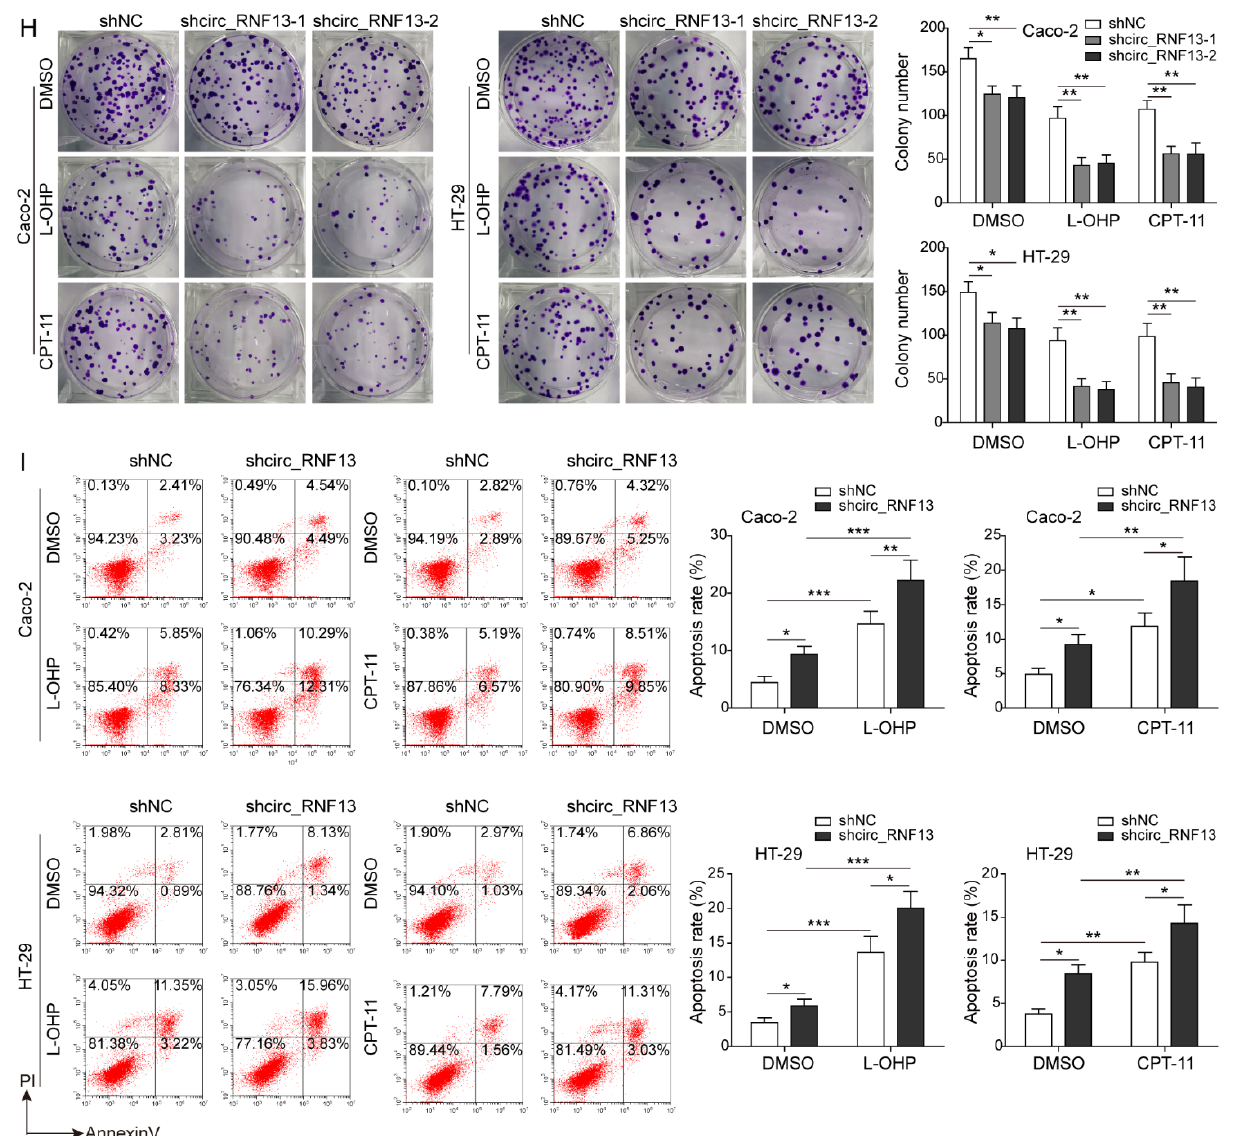
Figure 3. Knockdown of circ_RNF13 inhibits stemness and increases chemosensitivity in CRC cells. ( A ) The circ_RNF13 level in CRC cells was detected by qRT-PCR. ( B ) The protein level of DDX27 was detected by Western blot analysis. ( C ) The sphere-forming abilities of CRC cells were monitored by sphere formation assay. ( D ) The cell population of CD44 + CD133 + cells was detected by flow cytometry. ( E ) The CD44 or CD133 level in CRC cells was detected by IF staining. Red, CD44; green, CD133; blue, DAPI. Scale bar, 25 μ m. ( F ) The protein levels of stemness markers (CD44, CD133, SOX2, OCT4, and NANOG) were detected by Western blot analysis. ( G ) Cell via- bility was monitored by CCK-8 assay. ( H ) The colony-forming abilities of CRC cells were assessed by colony formation assay. ( I ) Cell apoptosis was measured by Annexin V-FITC/PI staining. Each experiment was performed at least three times independently. *, p < 0.05, **, p < 0.01, ***, p < 0.001. Full pictures of the Western blots are presented in Figure S2.